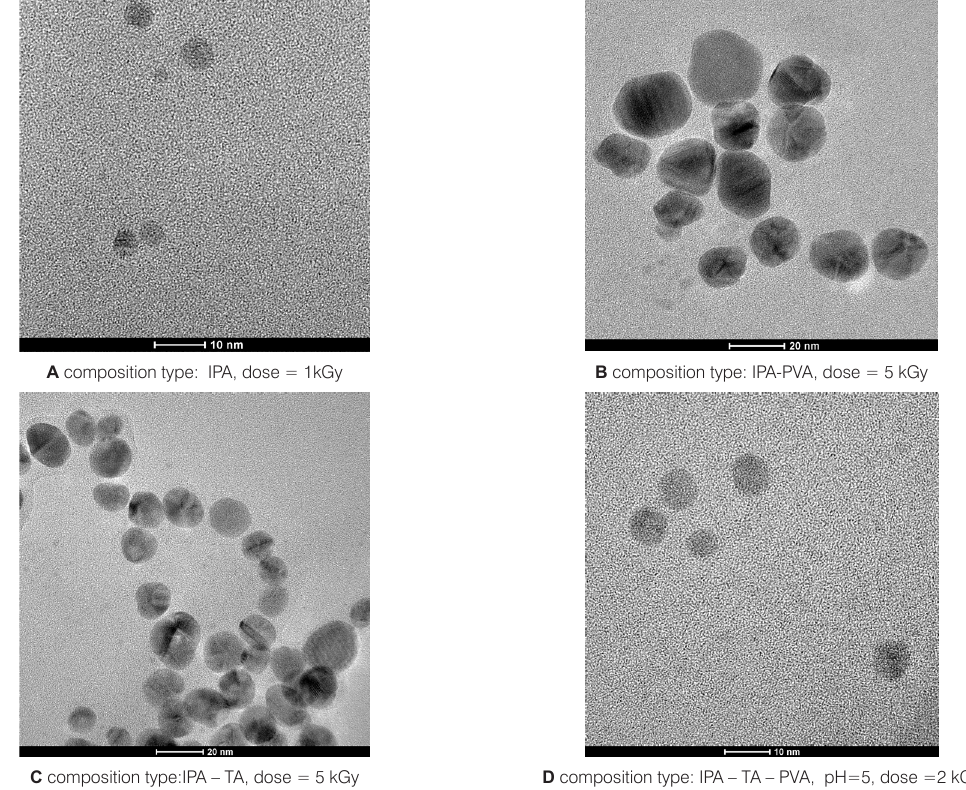
Figure 3. TEM images for AgNPs obtained by irradiation at a low dose rate and different compositions.